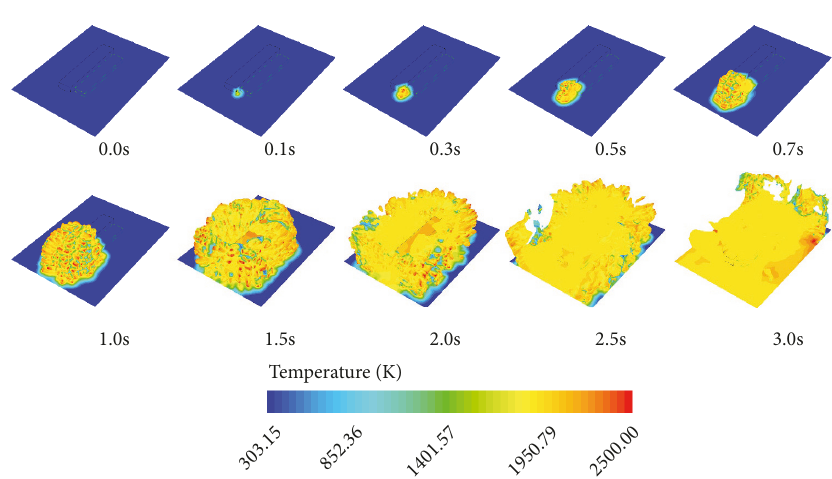
Figure 9: Natural gas deflagration at fuel volume fraction 10.4% (equivalence ratio 𝜑 = 1.1